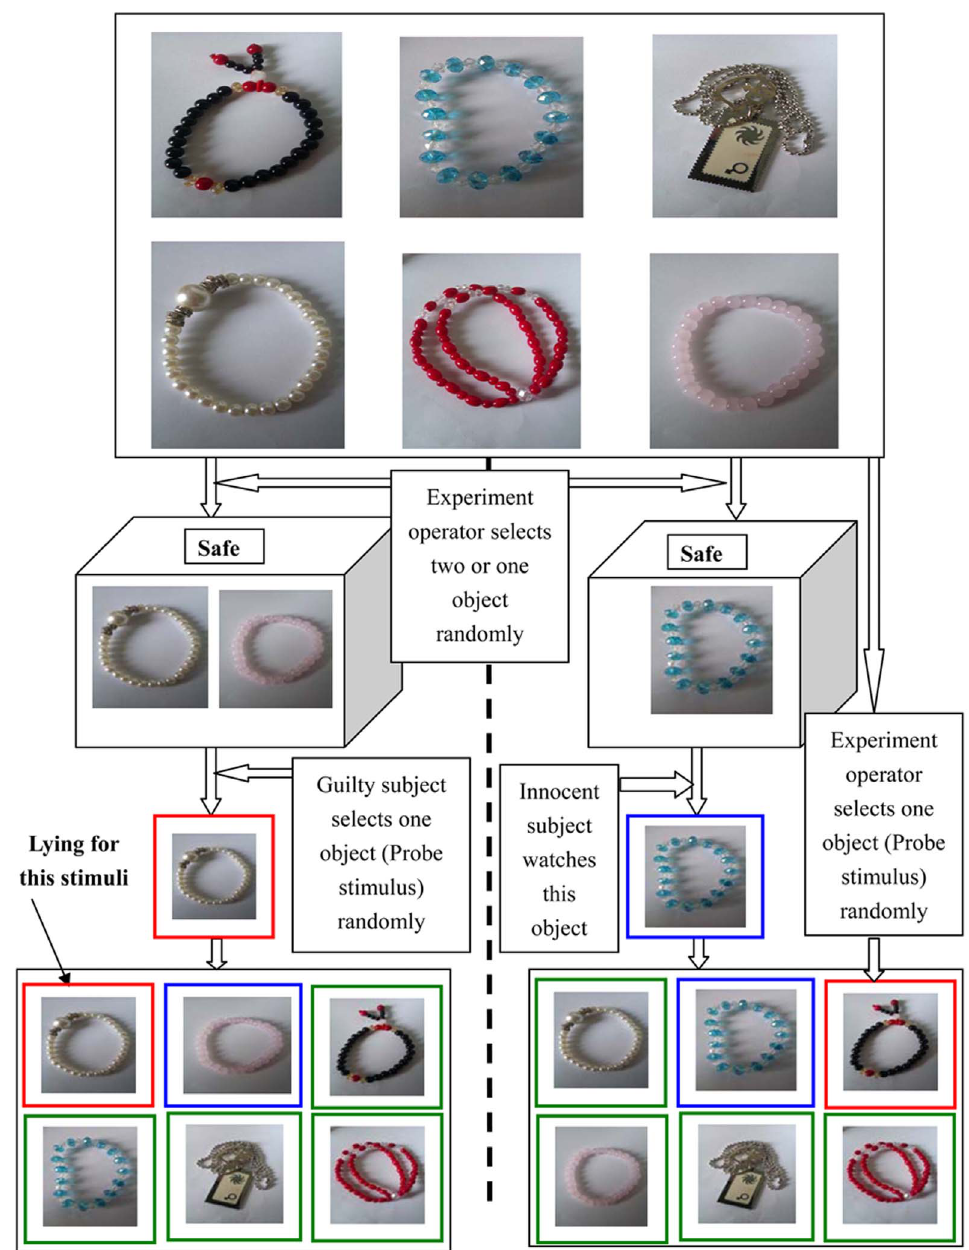
Figure 2. The sketch map of stimuli protocol. The left part and right parts of the dashed line represent the experimental protocol for guilty and innocent subjects, respectively. The pictures with red, blue and green rectangles represents P, T and I stimuli,